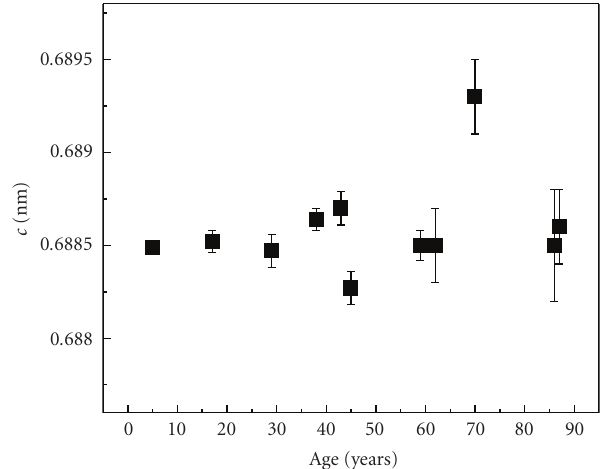
Figure 7: The wt% of carbonate loss of human dental apatite as a function age as evaluated from di ff erential thermogravimetric